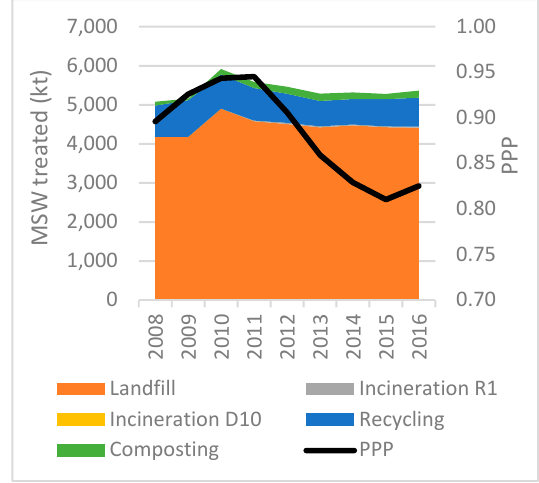
Figure 16. Waste treatment method and PPP in Greece 2008–2017 (EUROSTAT 2019b, 2019c).